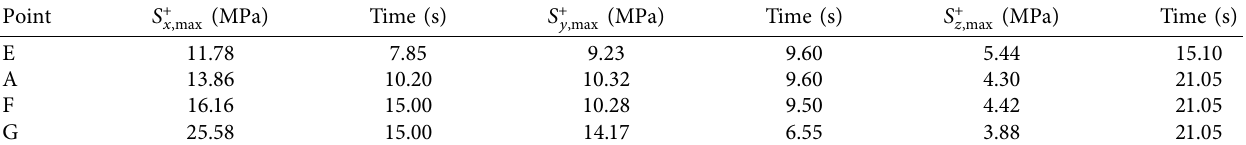
Table 6: Maximum variations in dynamic